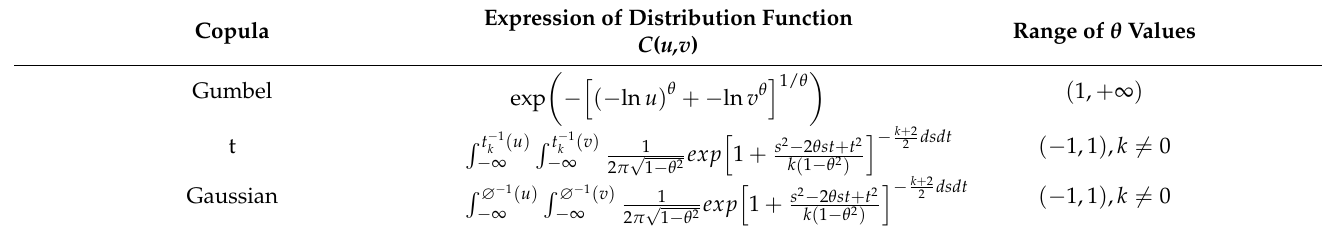
Table 1. Cont. Expression of Distribution Copula